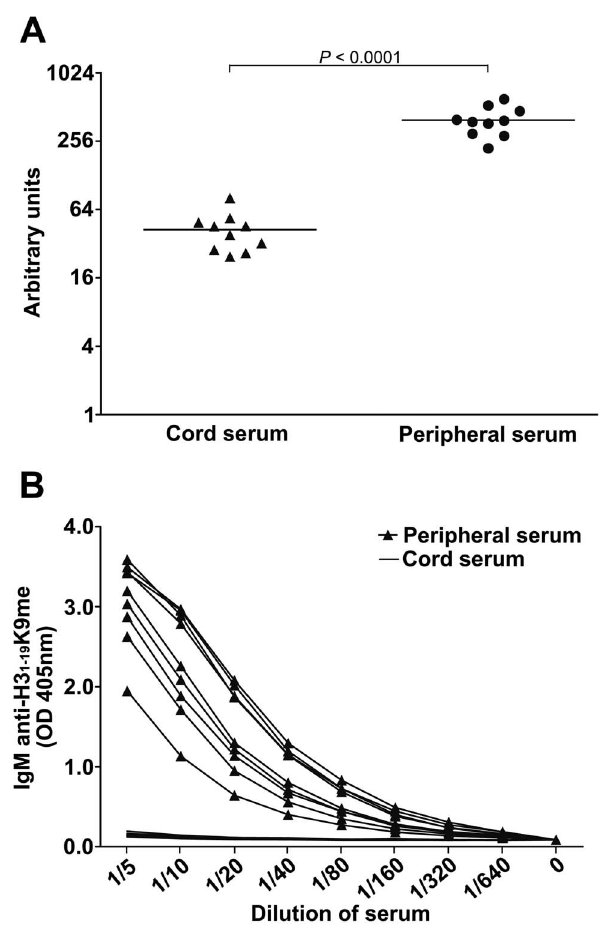
Figure 9. Comparison of anti-H3 1 – 19 K9me IgM in sera from peripheral blood and umbilical cord blood. (A) Comparison of total IgM concentration in sera. KT16 anti-human IgM was used as the capture Ab and HRP-conjugated KT38 was used as the detection Ab. Concentrations of IgM are represented as arbitrary units calculated using a serum titration curve. The horizontal bars indicate the mean values in each group. P value was calculated using Student’s t test. (B) Anti-H3 1–19 K9me IgM in 9 peripheral serum samples from healthy children or in 10 cord serum samples. Microtiter plates were coated with H3 1–19 K9me peptides conjugated to BSA. KT16 anti-human IgM was used as the primary Ab and HRP-conjugated goat anti-mouse IgG was used as the secondary Ab. The results are representative of three separate